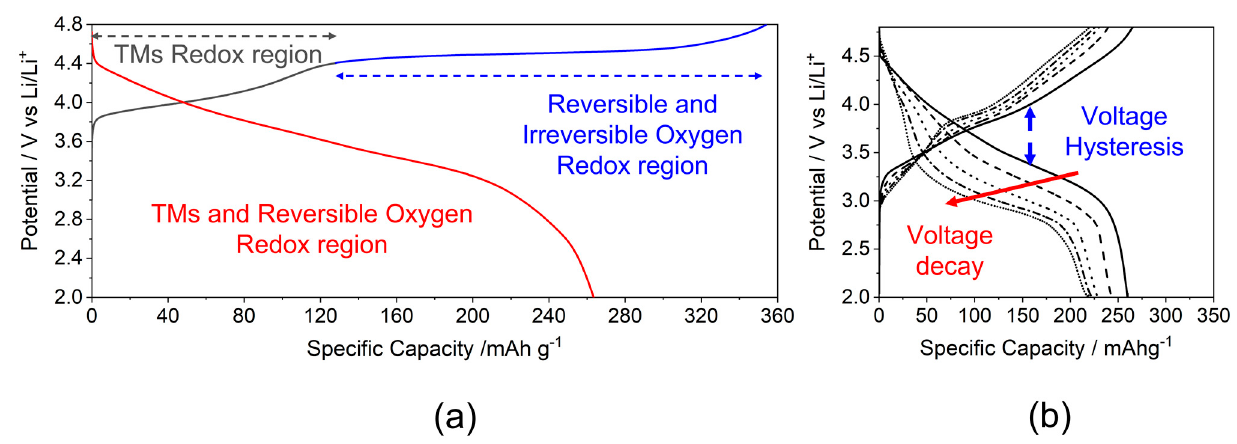
Figure 3. Typical potential profile of LRLOs ( a ) upon first cycle and ( b ) during prolonged cycling.